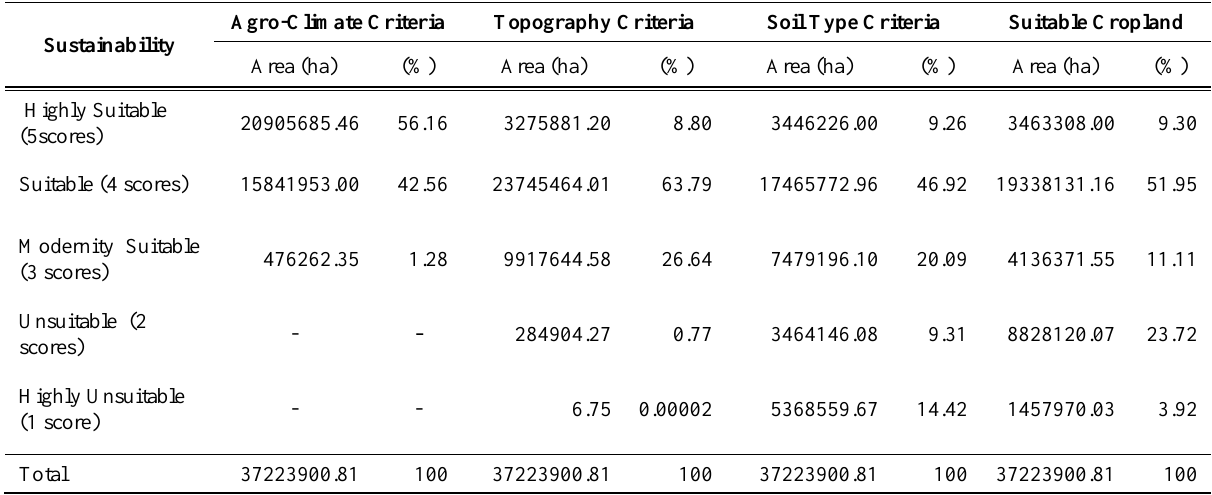
Table 2. Surface area occupied by five cropland suitability classes of central agriculture region of Mongolia in three different criteria.